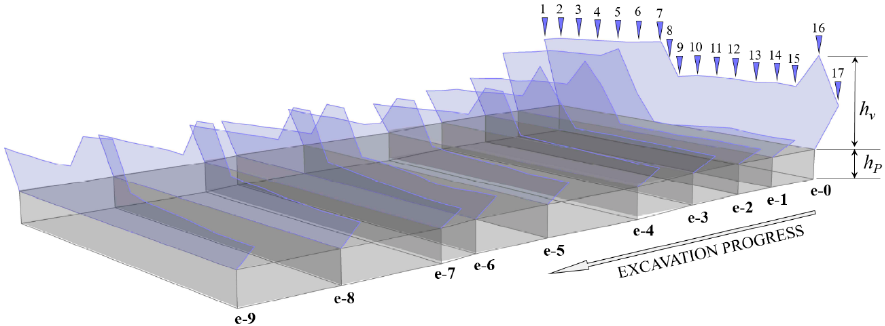
Figure 4. Progress of excavation in nine epochs and the measured excavation height at 17 points for each epoch. Table 2. Total excavation heights for 17 points across excavation front at every epoch. Point ID Epoch